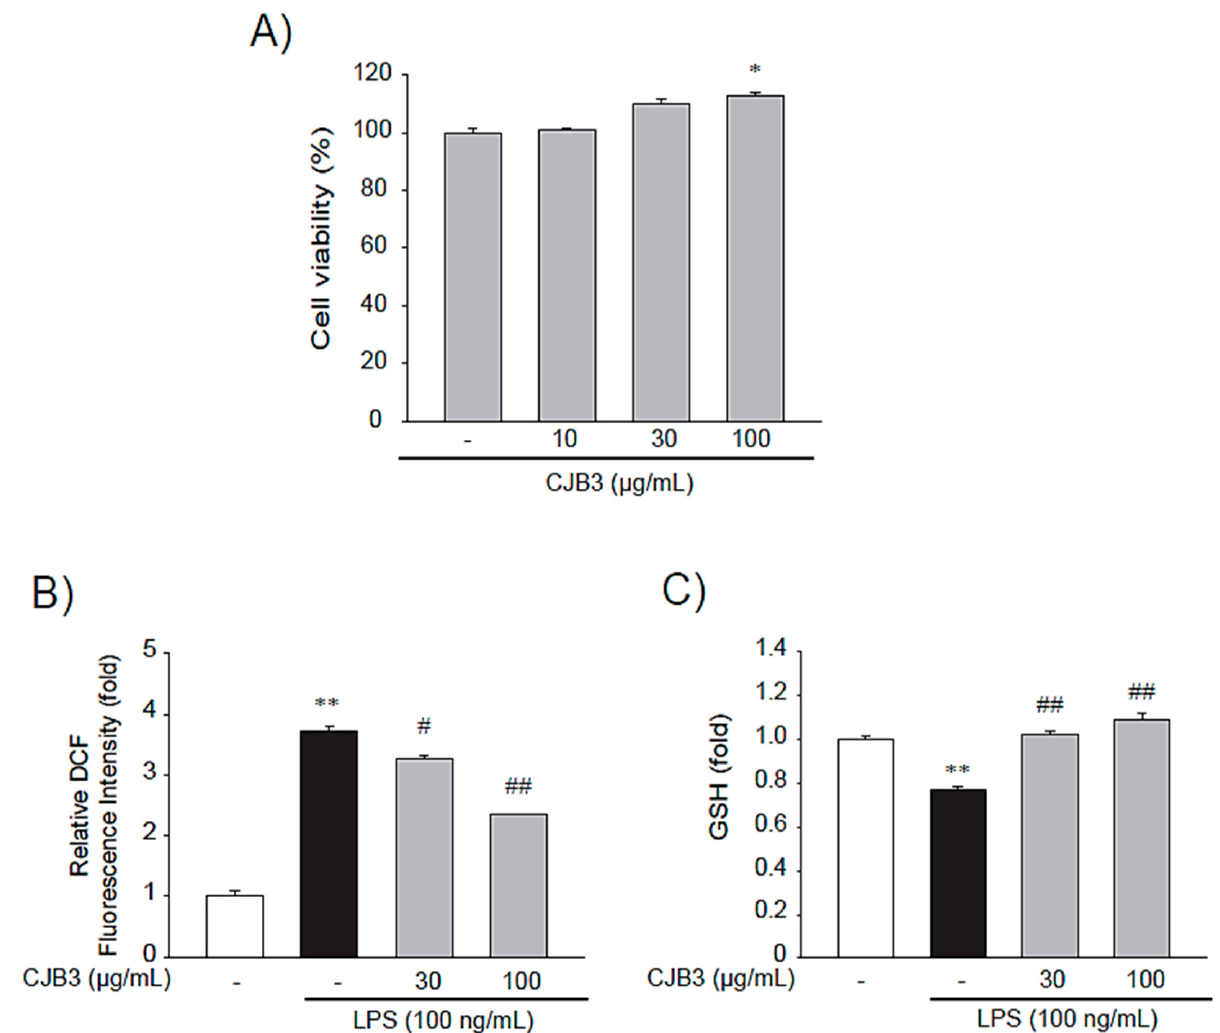
Figure 4. The inhibitory effect of CJB3 on LPS-induced oxidative stress in RAW264.7 cells. ( A ) The cytotoxicity of CJB3 in Raw 264.7 cells: cells were treated with CJB3 (10–100 μ g/mL) for 24 h, and cytotoxicity was determined using 3-(4,5-dimethylthiazol-2-yl)-2,5-diphenyl tetrazolium bromide (MTT) assays. The effect of CJB3 on lipopolysaccharide (LPS)-induced reactive oxygen species (ROS) production: cells were treated with CJB3 (30 or 100 μ g/mL) for 1 h and incubated with LPS for 3 h. ( B ) Cells were stained with 10 μ M 2 ′ -7 ′ -dichlorofluorescin diacetate (DCFH-DA) for 30 min at 37 °C. Intracellular fluorescence intensities were measured using a fluorescence microplate reader. ( C ) The glutathione (GSH) concentrations were measured in the cell lysates treated with LPS and/or 10–30 μ g/mL CJB3 for 12 h. Data are expressed as the mean ± standard error of the mean (SE) of three replicates; ** p < 0.01, * p < 0.05, significant vs. vehicle-treated control; ## p < 0.01, # p < 0.05, significant vs. LPS